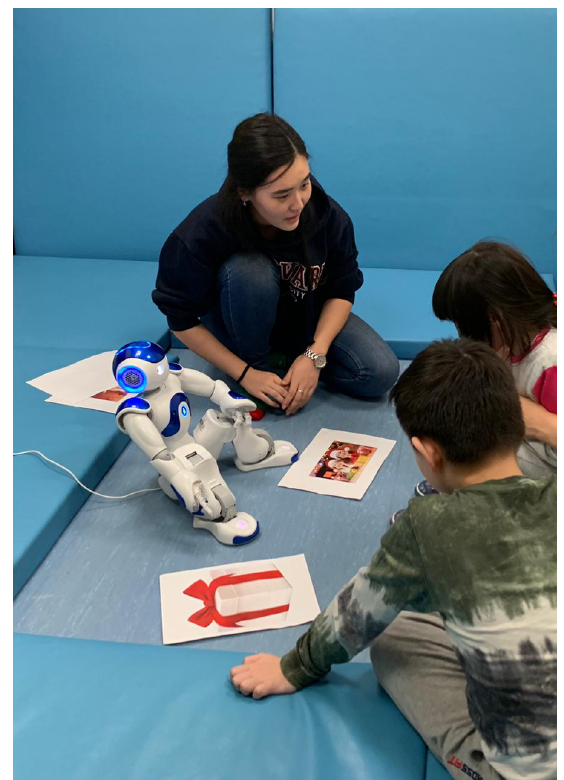
Figure 2: Experimental setup during second interaction design